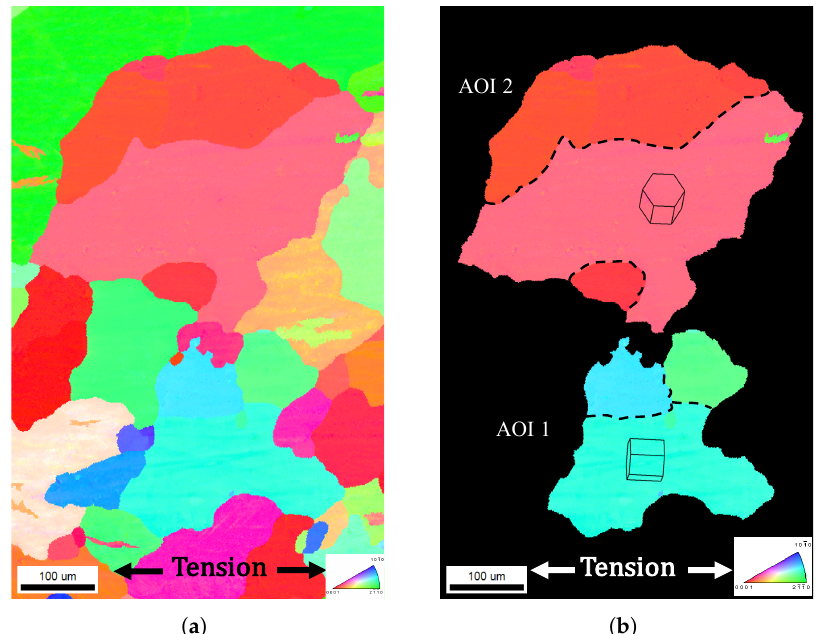
Figure 6. ( a ) Inverse pole figure (IPF) map generated through electron backscatter diffraction (EBSD) scans showing initial microstructure of Mg AM30 before deformation and ( b ) the highlighted partitions of the areas of interests (AOI 1 and AOI 2) with discrete unit crystal orientations that are the focus of